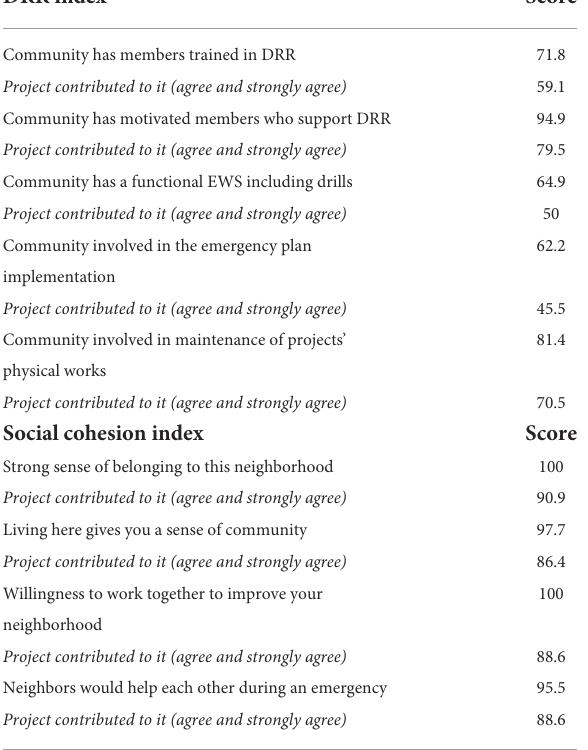
TABLE 2 External evaluation of GOAL’s contribution to DRR and social cohesion through their EWRS programming, adapted from Florida